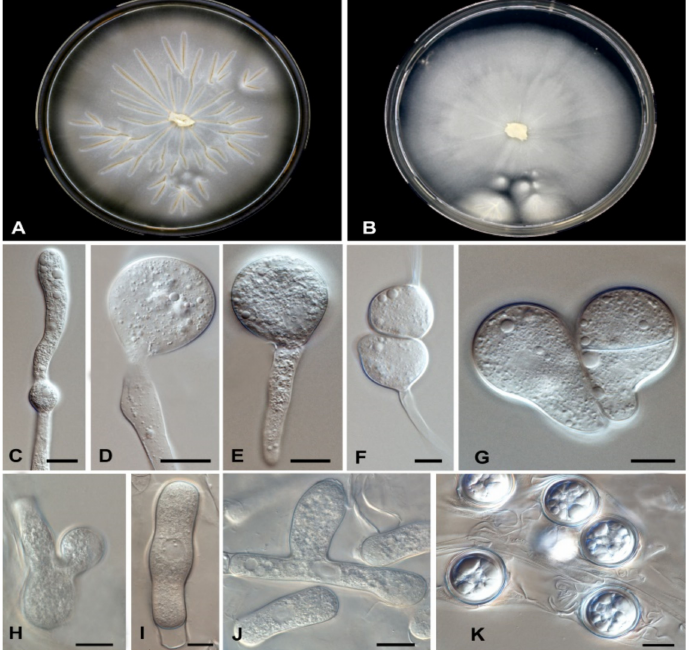
Figure 7. Basidiobolus omanensis . A colony on ( A ) MEA, ( B ) SAB after 3–5 days at 25 ◦ C, ( C ) mycelia with young chlamydospore, ( D ) primary conidiophore arising from mycelia, ( E ) primary conidia, ( F ) formation of zygospores, ( G ) mature septate conidia, ( H ) mature zygospores, ( I , J ) branched and unbranched hyphae, ( K ) mature zygospores. Bars 10 µ